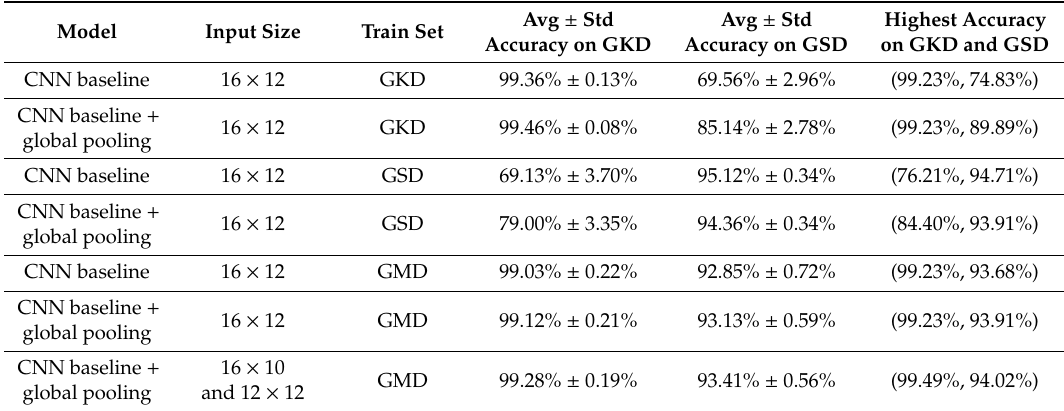
Table 3. Comparisons of structures w / o global pooling.